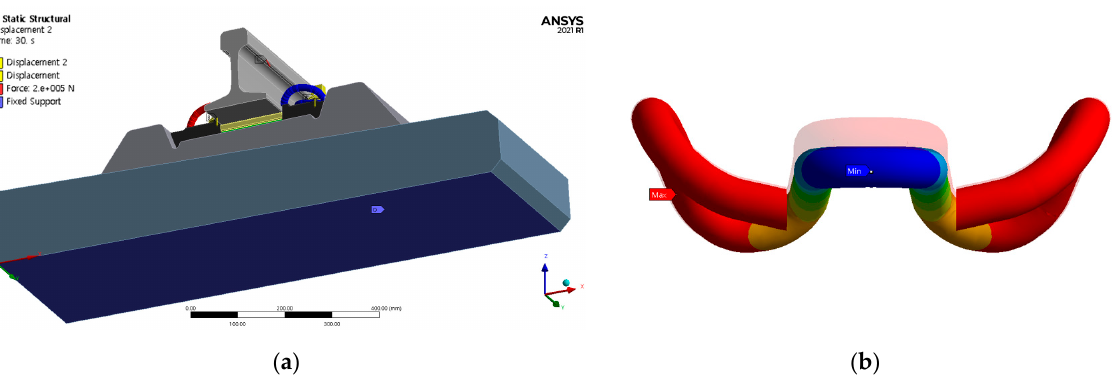
Figure 12. Overview of load s applied to rail and tension clamp. ( a ) Loading condition s . ( b ) Dis- placement control considering clamping force.